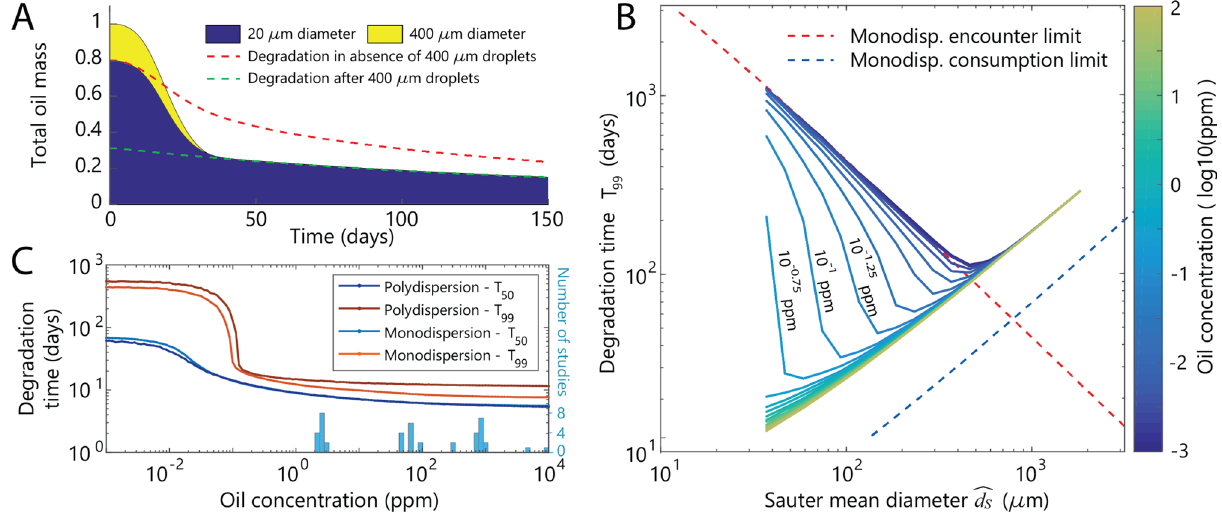
Figure 4. Degradation of polydispersed oil droplets. (a) In a polydispersion, feedback from larger droplets (through shedding of progeny bacteria) can accelerate the degradation of smaller droplets and thus the overall degradation. A two-size dispersion (solid shading) containing both 20 µm diameter (80% in mass) and 400 µm diameter (20% in mass) droplets degrades more rapidly than the 20 µm diameter droplets alone (red dashed line). After the 400 µm droplets are consumed, the dispersion continues to degrade at the same rate as a dispersion of only 20 µm droplets that had started with 31% of the initial oil concentration (green dashed line). (b) Polydispersions also exhibit an optimal droplet size, here expressed as an optimal Sauter mean diameter. For log-normal polydispersions (Supplementary Fig. 6) the dependence of the optimal Sauter mean diameter on initial oil concentration (colormap) is similar to that of monodispersions (Fig. 3c). The theoretical limit lines (dashed) are as in Fig. 3c. (c) For a given size (Sauter mean diameter 62 µm), the degradation time ( T 99 ) of a polydispersion is always longer than a monodispersion with the same diameter. The model considered 50,000 droplets. The transition to being encounter-limited (increased T 99 at low starting oil concentration) also occurs at a slightly higher oil concentration for the polydispersion. The commonly used half-life metric ( T 50 ) shows very little difference between poly- and monodispersions, but also greatly underestimates the impact of encounter limitation. A histogram of the oil concentrations used in experimental studies recently reviewed 18 is shown in light